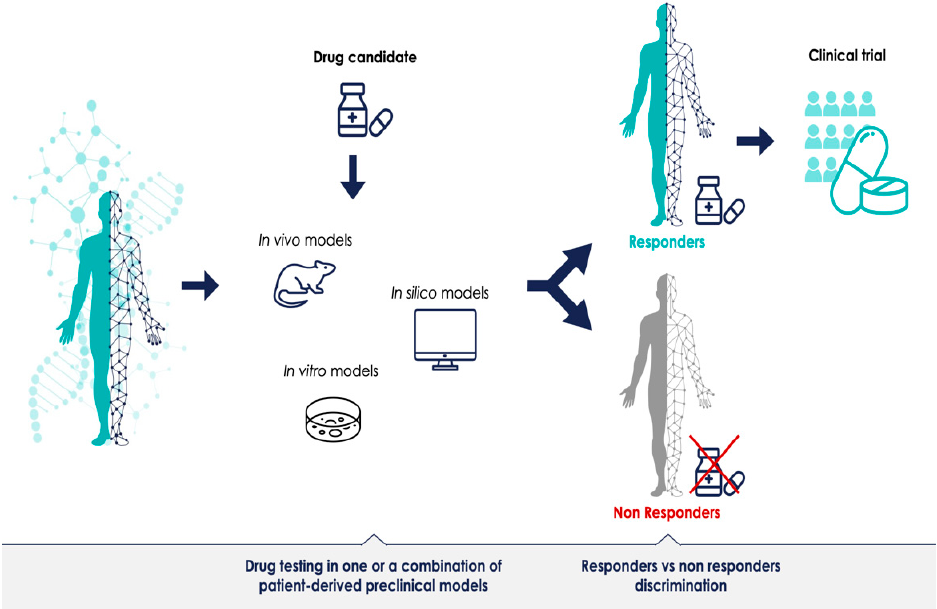
Figure 1. Predictive patient-derived translational models for personalized medicine. Preclinical development in clinically relevant models with robust predictions could improve clinical trials for personalized medicine.